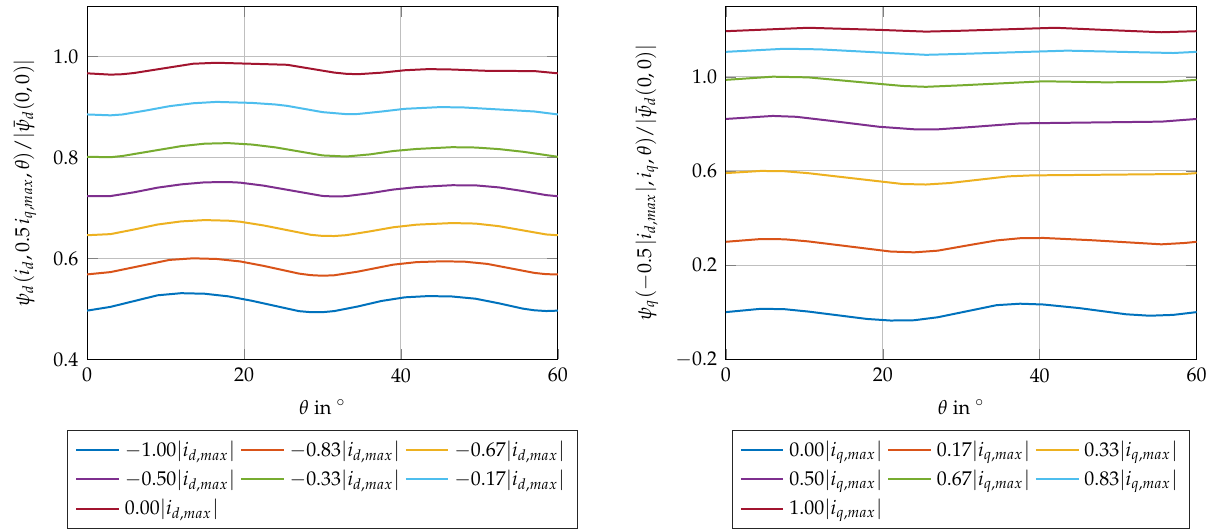
Figure 1. Exemplary flux linkage characteristics of the considered machine, normalised by the averaged flux linkage ¯ ψ d ( 0,0 ) due to the permanent